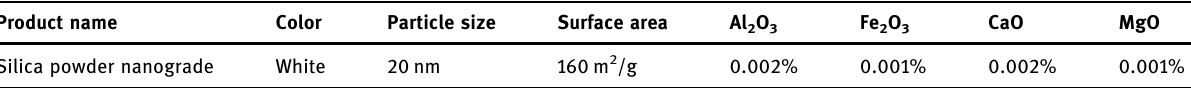
Table 2: Properties of silica nanoparticles according data sheet